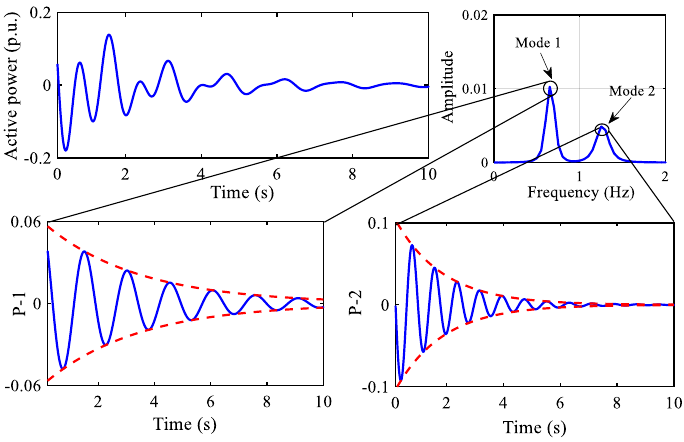
Table 2. Oscillation parameters of active power in line.